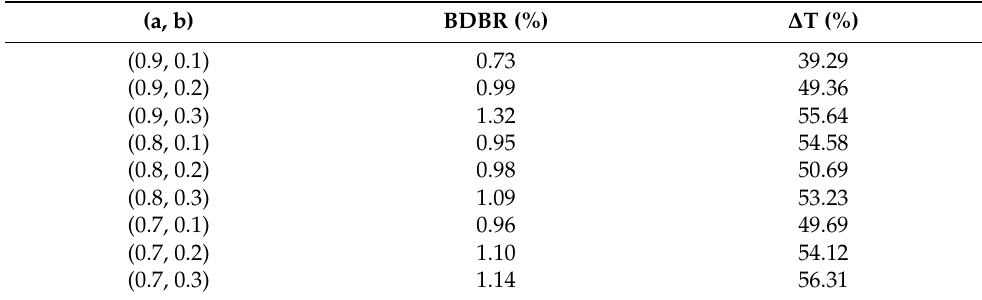
Table 2. Algorithm performance at different